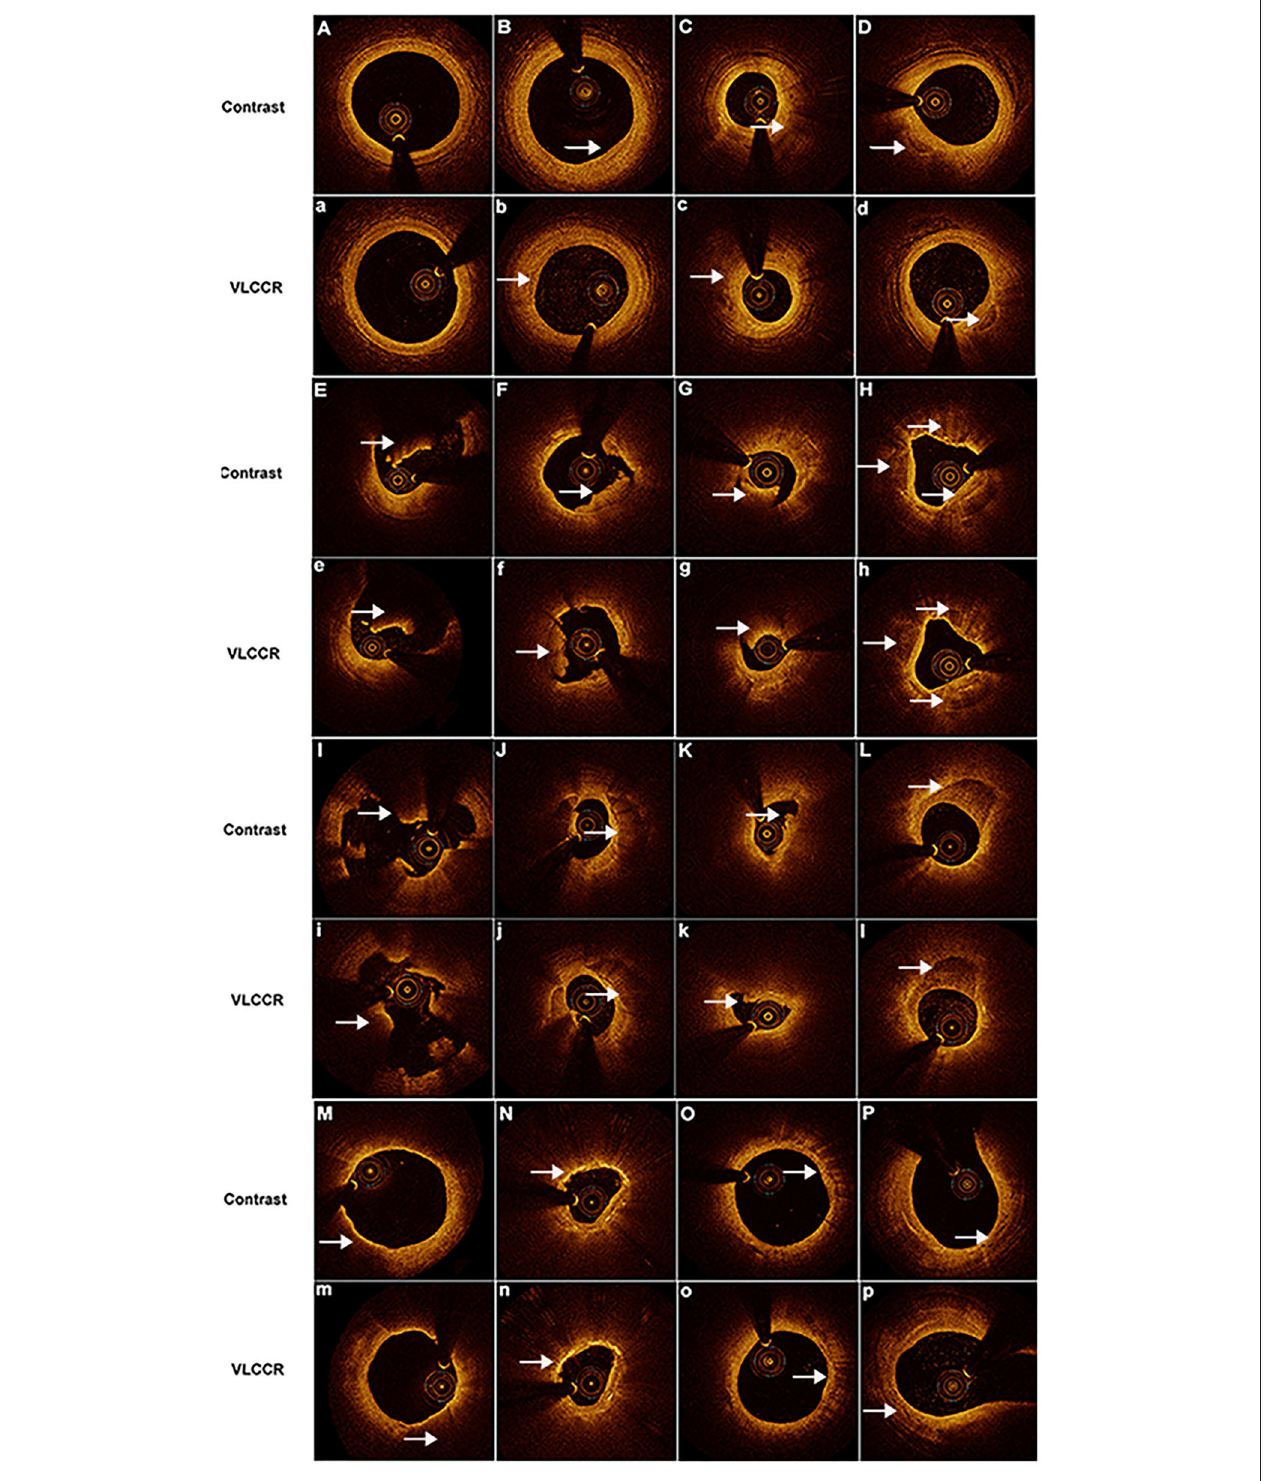
FIGURE 3 | Representative images obtained by OCT with contrast media and VLCCR at the culprit lesion site in ACS patients with different coronary atherosclerotic plaques. Clear images were acquired with both contrast media (Capital) and VLCCR (lower case). (A,a) normal vessel; (B,b) fibrous plaque; (C,c) lipid-laden plaque; (D,d) fibrocalcific plaque; (E,e) red thrombus; (F,f) white thrombus; (G,g) mixed thrombus; (H,h) healed plaque; (I,i) plaque rupture; (J,j, K,k) plaque erosion; (L,l) calcific plaque; (M,n) thin-cap fibroatheroma; (N,n) cholesterol crystal; (O,o) macrophage; and (P,p) microchannel. White arrow indicates the imaging characteristic of